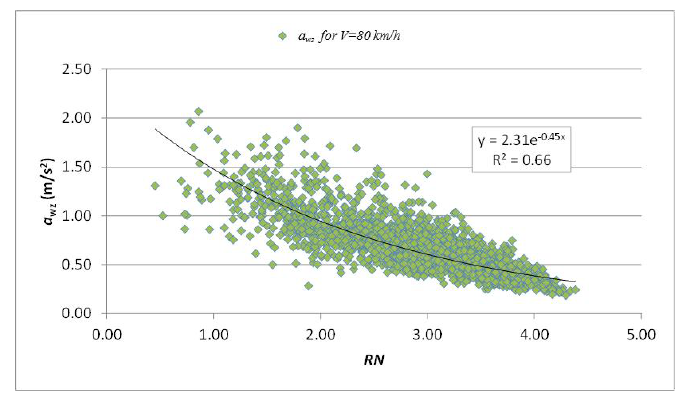
Figure 9. Correlation between RQI Mn and a wz at 100 km/h.